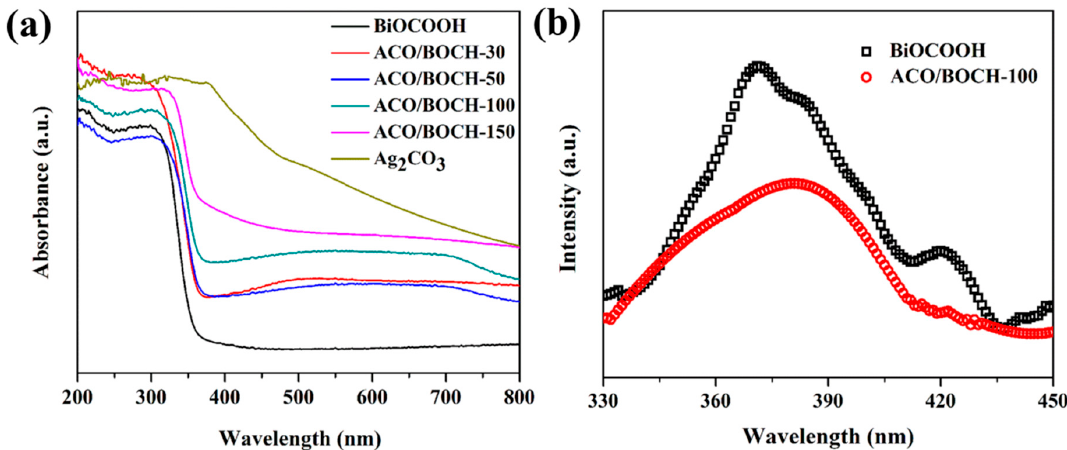
Figure 4. ( a ) UV-vis DRS of pure BiOCOOH, Ag 2 CO 3 , and Ag 2 CO 3 /BiOCOOH heterojunctions (ACO/BOCH-30, ACO/BOCH-50, ACO/BOCH-100, and ACO/BOCH-150). ( b ) PL spectra of pure BiOCOOH and ACO/BOCH-100 with an excitation wavelength of 300 nm.